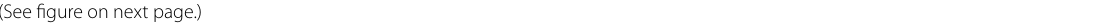
Fig. 6 A 46‑year‑old female homemaker patient, obese (BMI 41.4 kg/m 2 ), presented with significant posteromedial left knee pain with a popping = sound for 7 weeks (subacute stage) after stepping into a hole. By the comparison between the pre‑ and post‑varus stress medial meniscus extrusion amount (MME). Without varus stress position ( a and c ), the coronal PD‑SPAIR WI of the left knee shows an extruded medial meniscus of approximately 3.4 mm from the medial margin of the tibial plateau to the outer border of the extruded meniscus (orange arrow). With varus stress position ( b and d ), shows an increased MME amount of approximately 6.8 mm (red